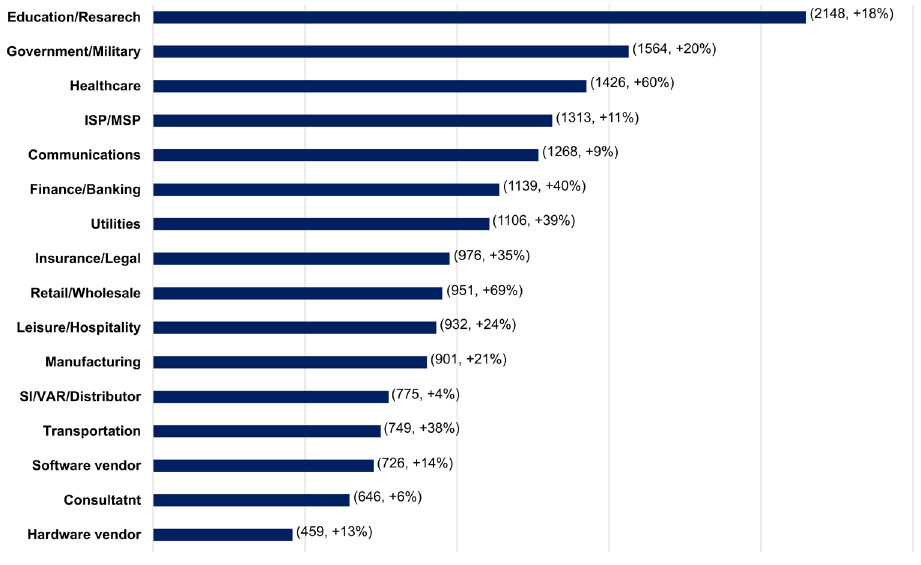
Figure 1. Average Weekly Cyber- attacks per Organization by Industry –Global 2022 Q3.